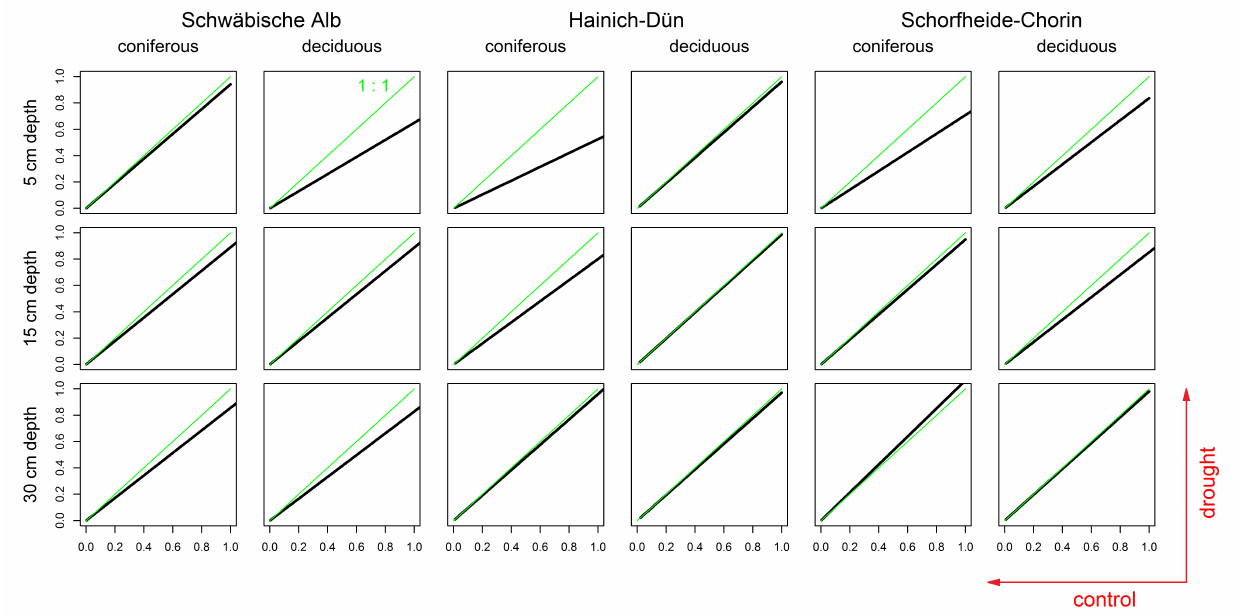
Figure 4. Normalized cumulated sums of soil moisture of the drought versus the control subplots of the investigated soils. The computations begin with the start of the rainfall reduction and end at the date of the dye tracer experiment